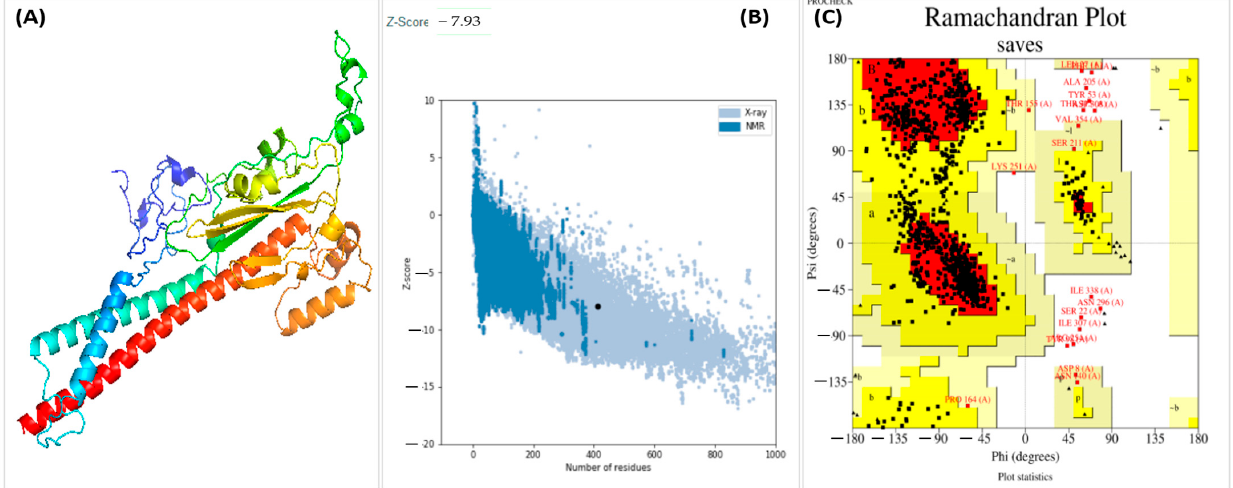
Figure 3. ( A ) Predicted 3D structure of vaccine construct. ( B ) ProSA web with z -score indicates overall model quality and recognizes errors in 3D model of vaccine construct. ( C ) Ramachandran plot describes the validation of the vaccine construct by showing amino acids in favored and allowed regions.